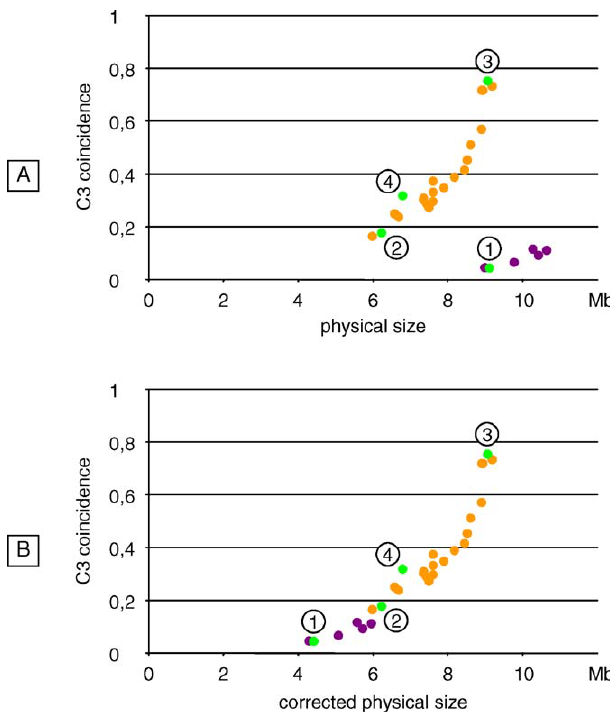
Figure 9. Scatter Plot between C3 Coincidence Value and Physical Size for Male Chromosome 4 Violet dots correspond to pairs of intervals encompassing the hetero- chromatic knob and the centromere, while orange dots correspond to the remaining pairs of intervals (all located on the long arm). Numbered green dots represent the same pairs of intervals than those represented in Figure 6A and used for the comparisons of C3 coincidence values. (A) Physical sizes were calculated from genome sequence data (Build 6 version 0), adding if necessary 1.5 Mb to take account for the